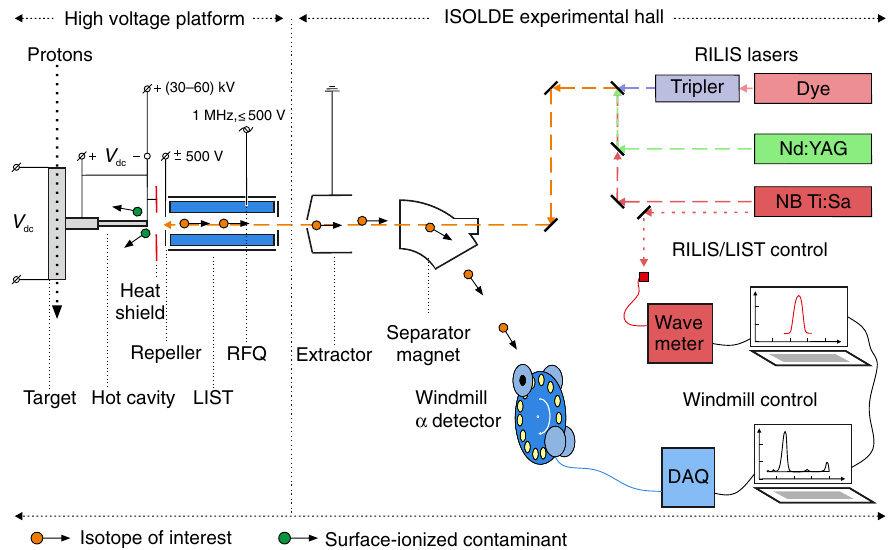
FIG. 1. An illustration of the LIST operated at the ISOLDE mass-separator facility. The LIST is attached to the target-ion-source assembly. Protons irradiate the target, and reaction products diffuse and effuse from the target into the LIST RFQ, where the atoms are ionized by the laser radiations. After extraction and acceleration by the extractor electrode at up to 60 kV, the ions are sent through the magnetic-dipole mass separator to the Windmill detection setup and data acquisition (DAQ). (NB) Ti:sapphire laser [41] at approximately 843.4 nm ( P ≈ 1 W, FWHM 0.8 GHz) for the scan of the transition to the 6 p 3 ð 4 S ∘ Þ 7 p 5 P 2 second excited state, and the 532-nm ( P > 10 W) second harmonic output of a neodymium- doped yttrium-aluminum-garnet (Nd:YAG) laser for the